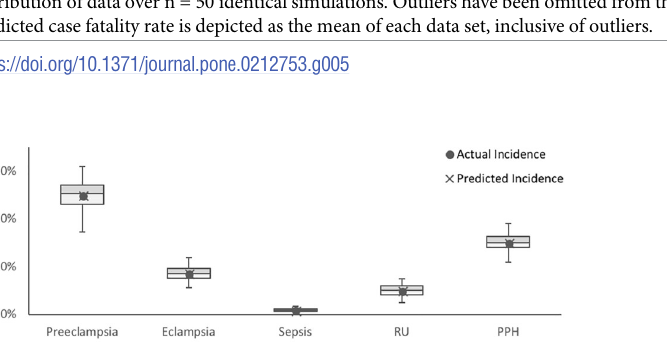
Fig 6. Comparison of complication incidence rates outputted by the calibrated model and complication incidence rates recorded by Herklots et al for the five complications incorporated in the model. Box plots represent distribution of data over n = 50 identical simulations. Outliers have been omitted from the box plots for clarity. Predicted case fatality rate is depicted as the mean of each data set, inclusive of